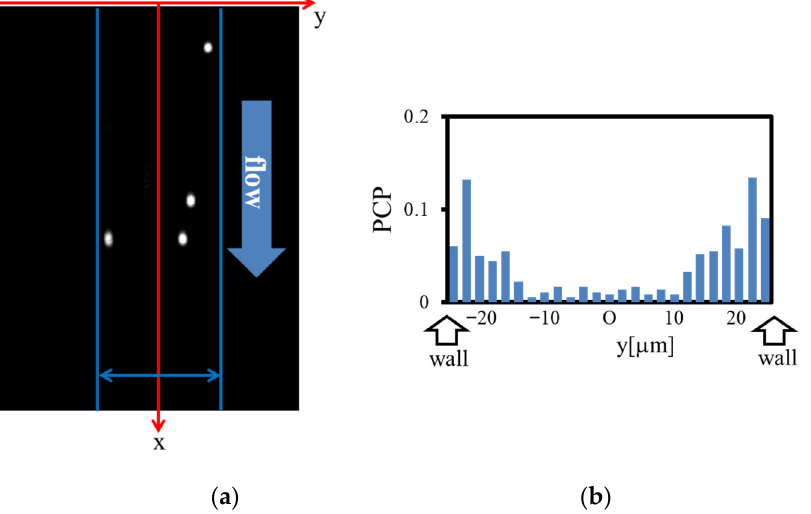
Figure 2. ( a ) Example of the fluorescence image obtained; ( b ) histogram representing the particle concentration profile (PCP) across the channel width.